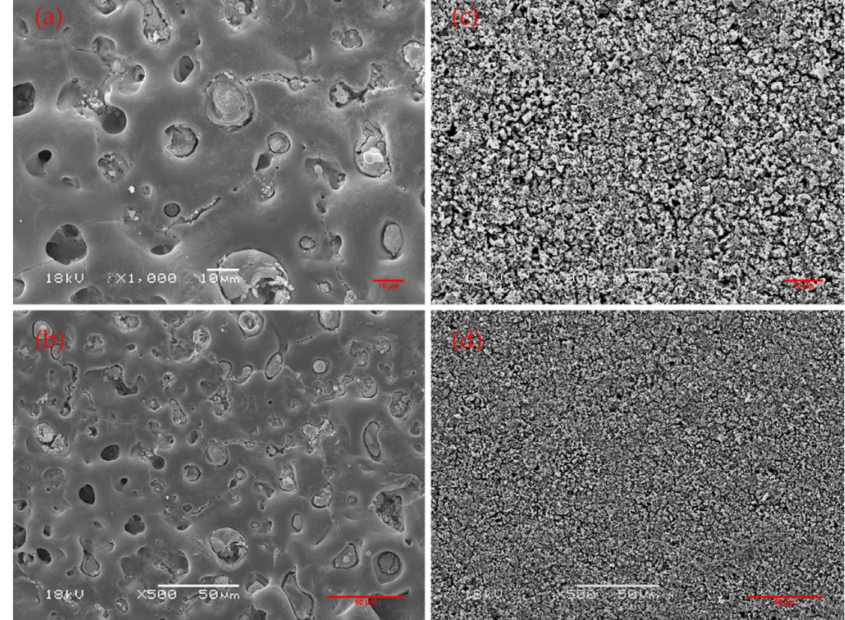
Figure 2. ( a ) Scanning electron microscopy (SEM) morphologies of the surface of the MgO coating at 1000 × , ( b ) SEM morphologies of surface of MgO coating at 500 × , ( c ) SEM morphologies of surface of ZrO 2 coating at 1000 × , and ( d ) SEM morphologies of surface of ZrO 2 coating at 500 ×